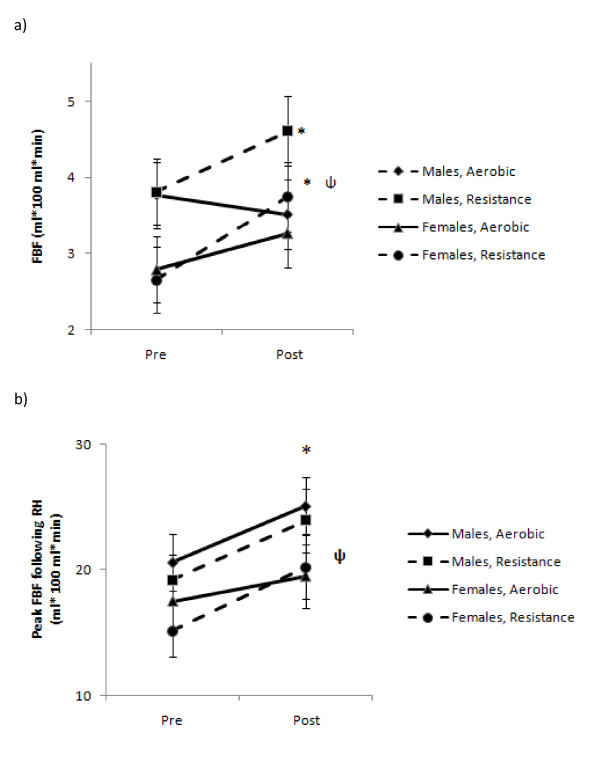
Changes in basal and peak forearm blood flow (FBF). (A) For basal FBF, there was a significant time × mode × sex interaction (ψ, P = 0.01) as resistance exercise (RE) produced greater increases in basal FBF compares with aerobic exercise (AE), and women had a significantly greater increase after RE than men (P = 0.042). (B) For peak FBF, there was a significant increase in peak blood flow after both exercise modes, and RE induced significantly higher peak blood flow (P = 0.04).